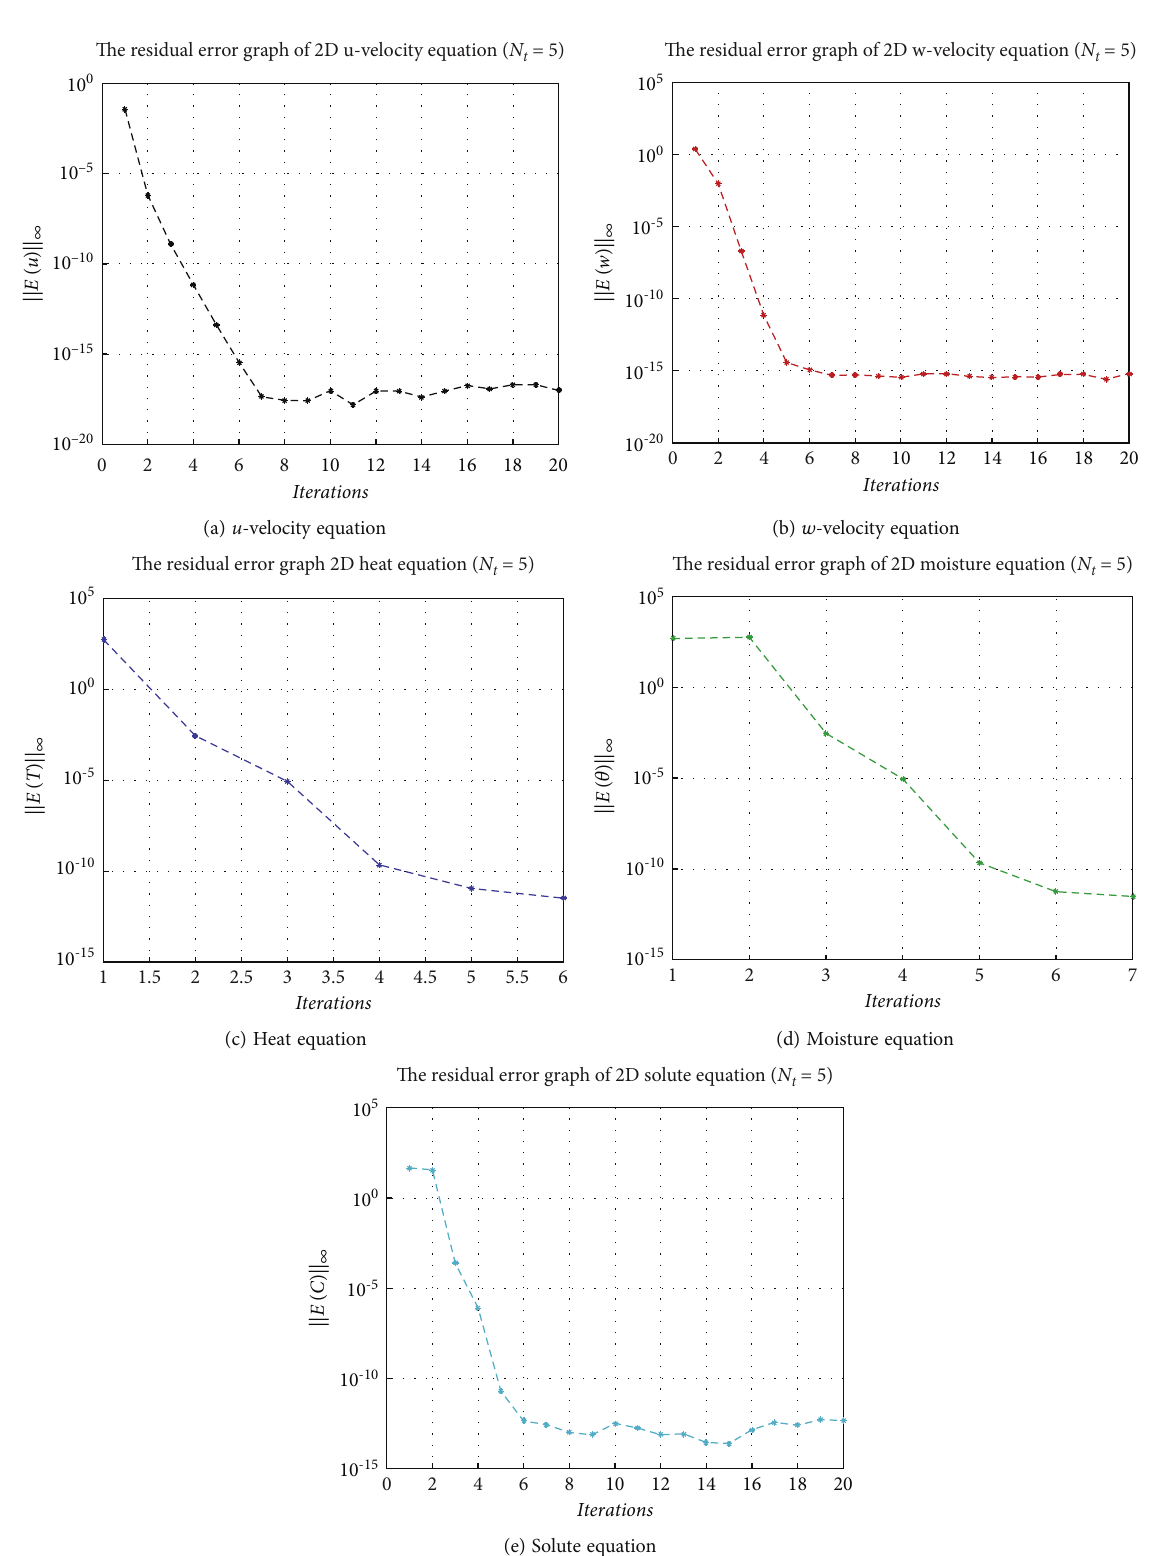
Figure 6: Error norms at di ff erent iteration points of the model, for N